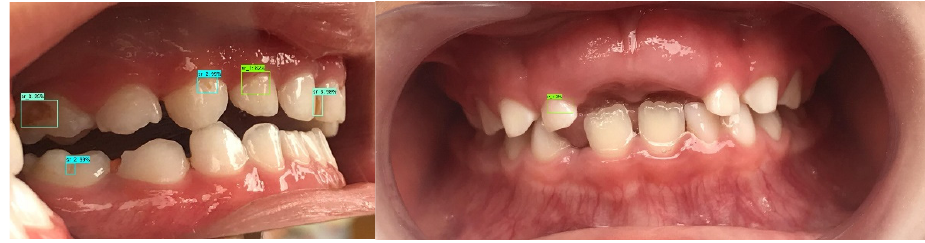
Figure 5. Faster R-CNN misdiagnosed a light reflection as a non-cavitated dental caries (green